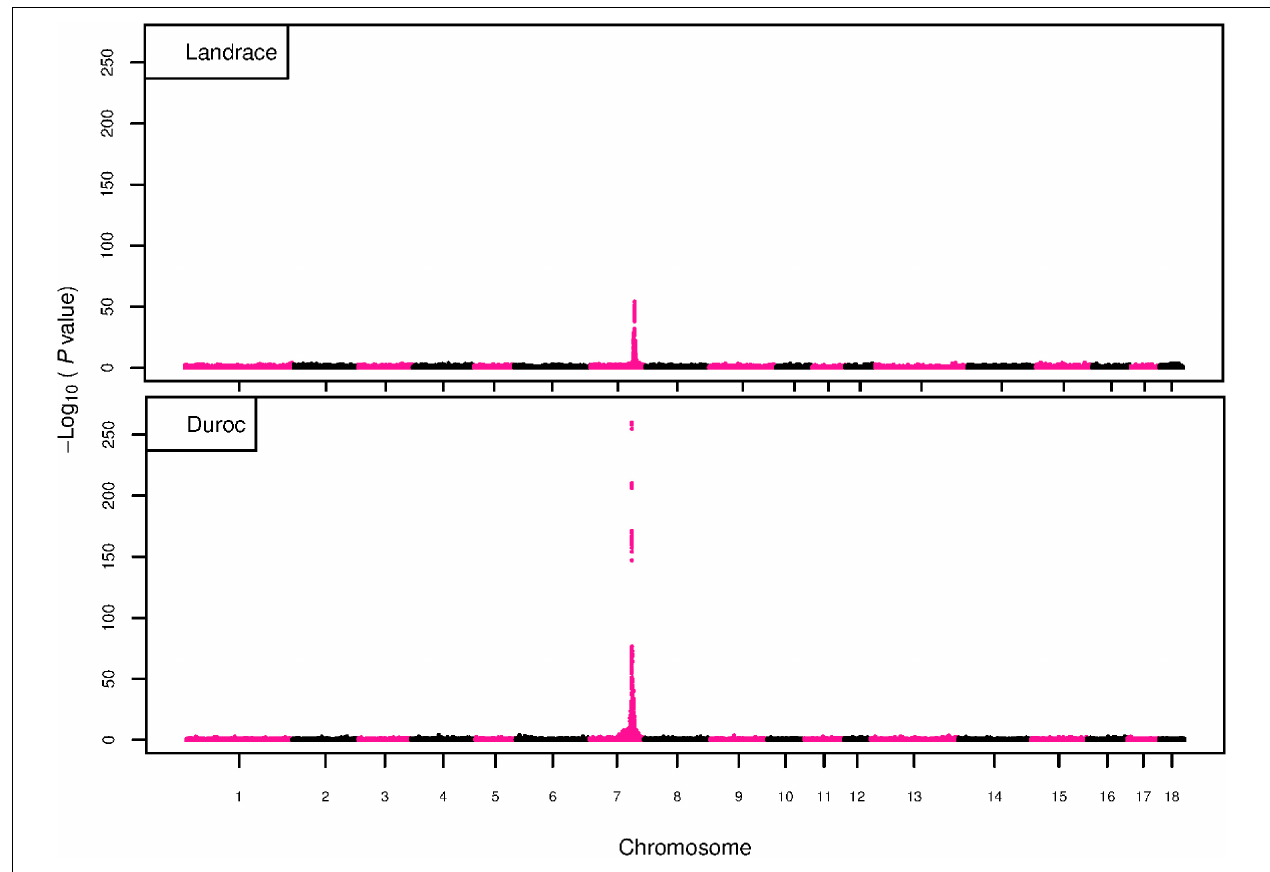
FIGURE 5 | GWAS plot for RIB with imputed 660K SNP chip data. On the y -axis is the –log 10 ( p -values) of single SNP association with RIB in L and D breeds. On the x -axis is the physical position of the SNP across the 18